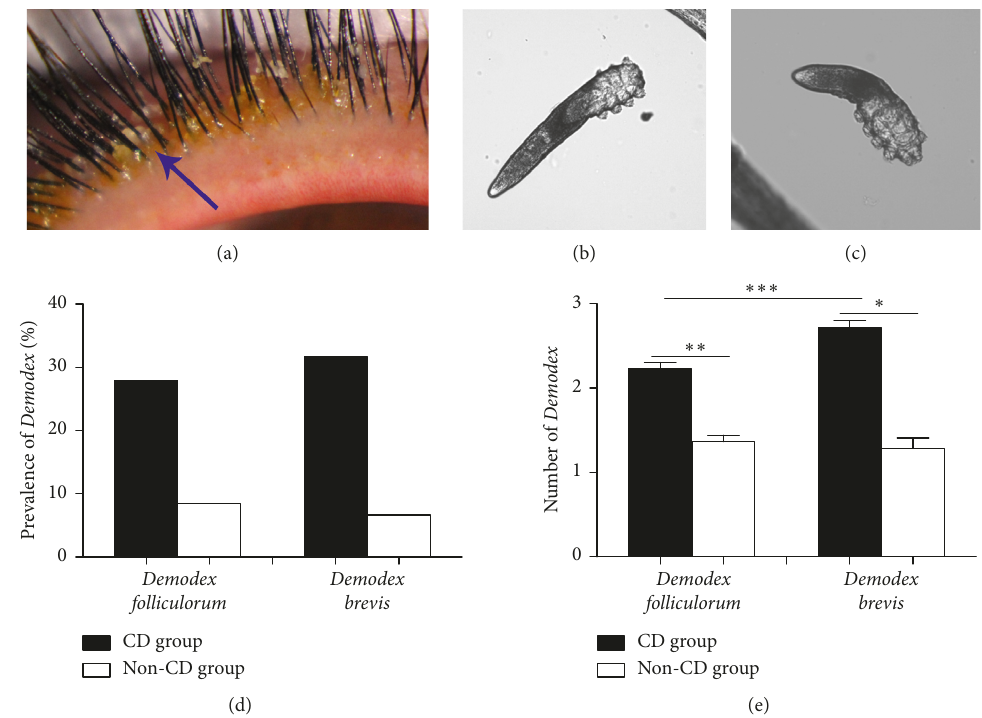
Figure 1: Representative images of cylindrical dandruff (a) (blue arrow; magnification 40x), Demodex folliculorum (b), and Demodex brevis (c); the prevalence of Demodex brevis was higher than that of Demodex folliculorum , and the average number of Demodex folliculorum was significantly lower than that of Demodex brevis (d, e).